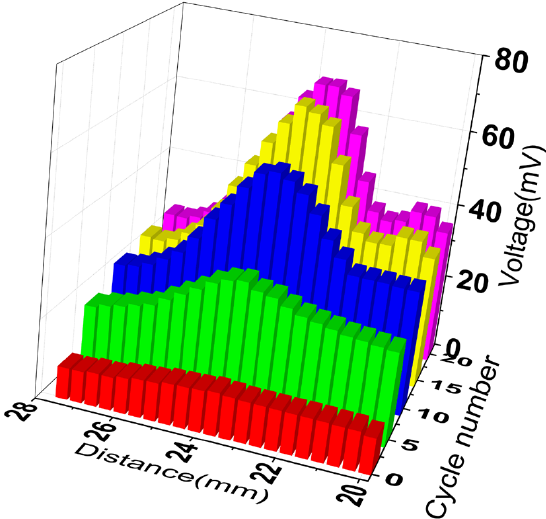
Figure 7. The peak-to-peak voltages at different locations under different excitation numbers.